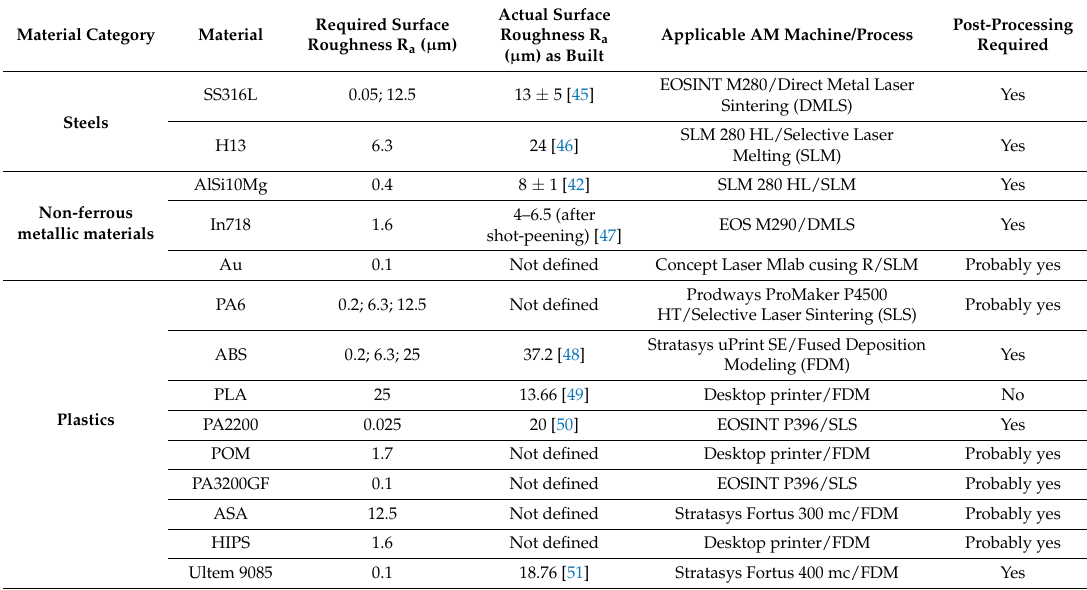
Table 3. Comparison of required and actual minimum surface roughnesses of applicable AM machines and processes to decide on the necessity of post-processing. If a literature source for the actual surface roughness of a specific material is not identified, the necessity of post-processing is estimated according to the underlying AM process